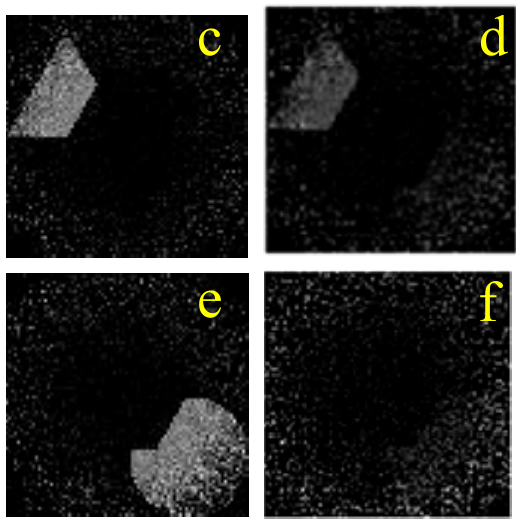
Figure 10. Comparative results based on NUTSM and UTSM. ( a ) is based on NUTSM and ( b ) is based on UTSM. ( c ) And ( e ) are the ghost image under the positions of ③ and ④ corresponding to ( a ). ( d ) And ( f ) are the ghost image under the positions of ⑤ and ⑦ corresponding to ( b ).